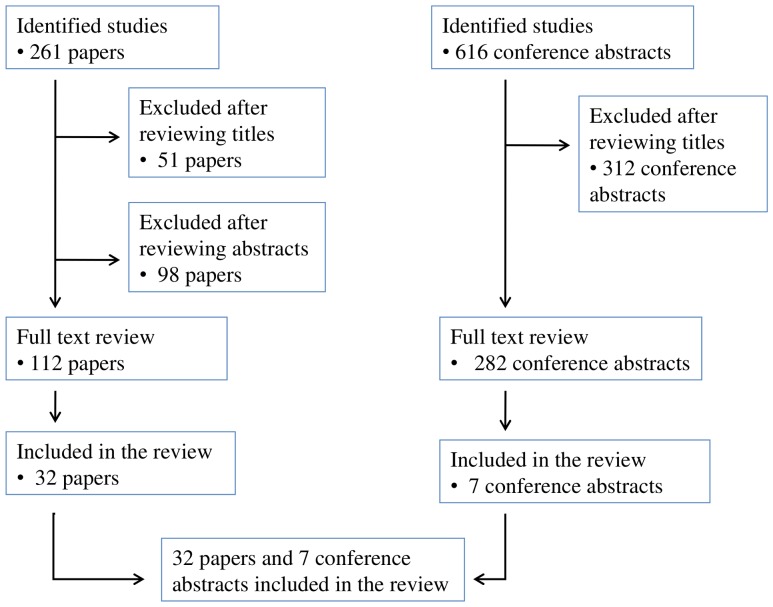
Search strategy and study selection.